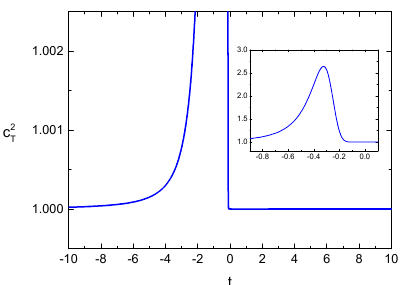
Figure 6. The dynamics of the sound speed of tensor perturbation c 2 time t . The positivity of c 2 c 2 = 1 in the neighborhood of t = 0